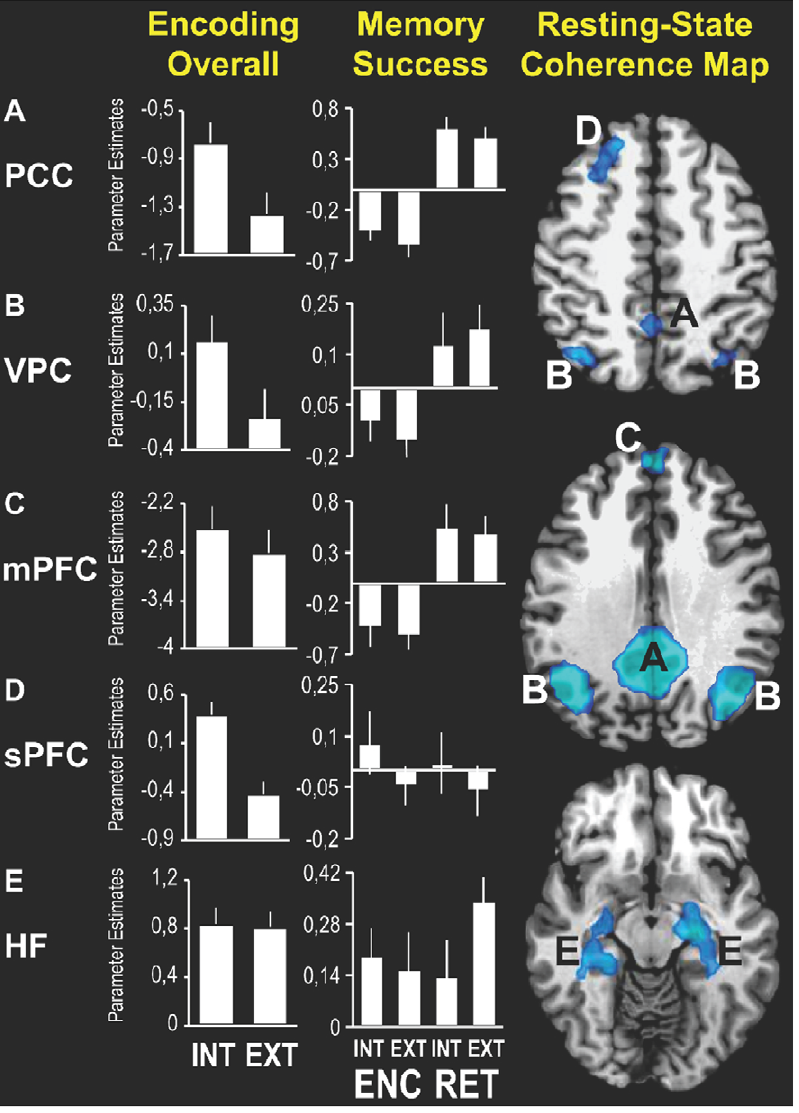
Figure 2. fMRI Results. Brain regions identified by the resting state analysis are depicted in blue (p , 0.005, FDR corrected, cluster size . 25 voxels): (A) posterior cingulate cortex, (B) ventral parietal cortex, (C) medial and (D) superior prefrontal cortex and (E) hippocampal formation. Bar graphs indicate mean cluster activity based on the memory-task (averaged over left and right sides in the case of bilateral activations). Left bar graphs show activity during encoding for internal (Int) and external (Ext) orienting conditions combined over hits and misses. Right bar graphs reflect the difference in activity between hits and misses for encoding (Int-Enc / Ext-Enc) and retrieval (Int-Ret / Ext-Ret). Vertical lines indicate SEMs.